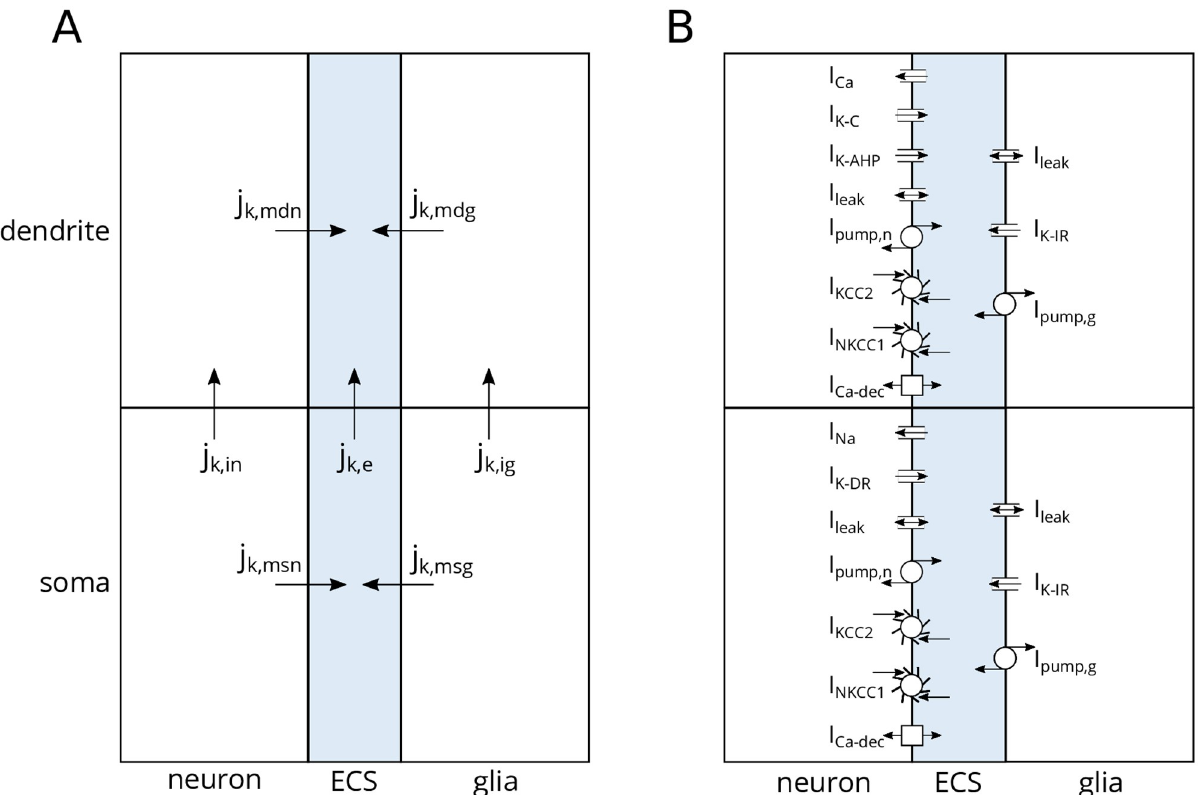
Fig 2. Model architecture. (A) The edNEG model contained three domains (neuron, index n , ECS, index e , and glia, index g ). Initial neuronal/ extracellular/glial volume fractions were 0.4/0.2/0.4. Each domain contained two compartments (soma level, index s , and dendrite level, index d ). Ions of species k were carried by two types of fluxes: transmembrane (index m ) fluxes ( j k,msn , j k,mdn , j k,msg , j k,mdg ) and intra-domain fluxes in the neuron ( j k,in ), the ECS ( j k,e ), and the glia cell ( j k,ig ). An electrodiffusive framework was used to calculate ion concentrations and electrical potentials in all compartments. (B) The neuronal membrane contained the same mechanisms as in [33]. Both compartments contained Na + , K + , and Cl − leak currents ( I leak ), 3Na + /2K + pumps ( I pump,n ), K + /Cl − cotransporters ( I KCC2 ), Na + /K + /2Cl − cotransporters ( I NKCC1 ), and Ca 2+ /2Na + exchangers ( I Ca − dec ). The soma contained Na + and K + delayed rectifier currents ( I Na and I K − DR ), and the dendrite contained a voltage-dependent Ca 2+ current ( I Ca ), a voltage- dependent K + afterhyperpolarization current ( I K ), and a Ca 2+ -dependent K + current ( I K ). The glial membrane mechanisms were taken from − AHP − C [47], and they were the same in both compartments. They included Na + and Cl - leak currents ( I leak ), inward rectifying K + currents ( I K − IR ), and 3Na + / 2K + pumps ( I pump,g ). The edNEG model also accounted for cellular swelling due to osmotic pressure gradients across the membranes.